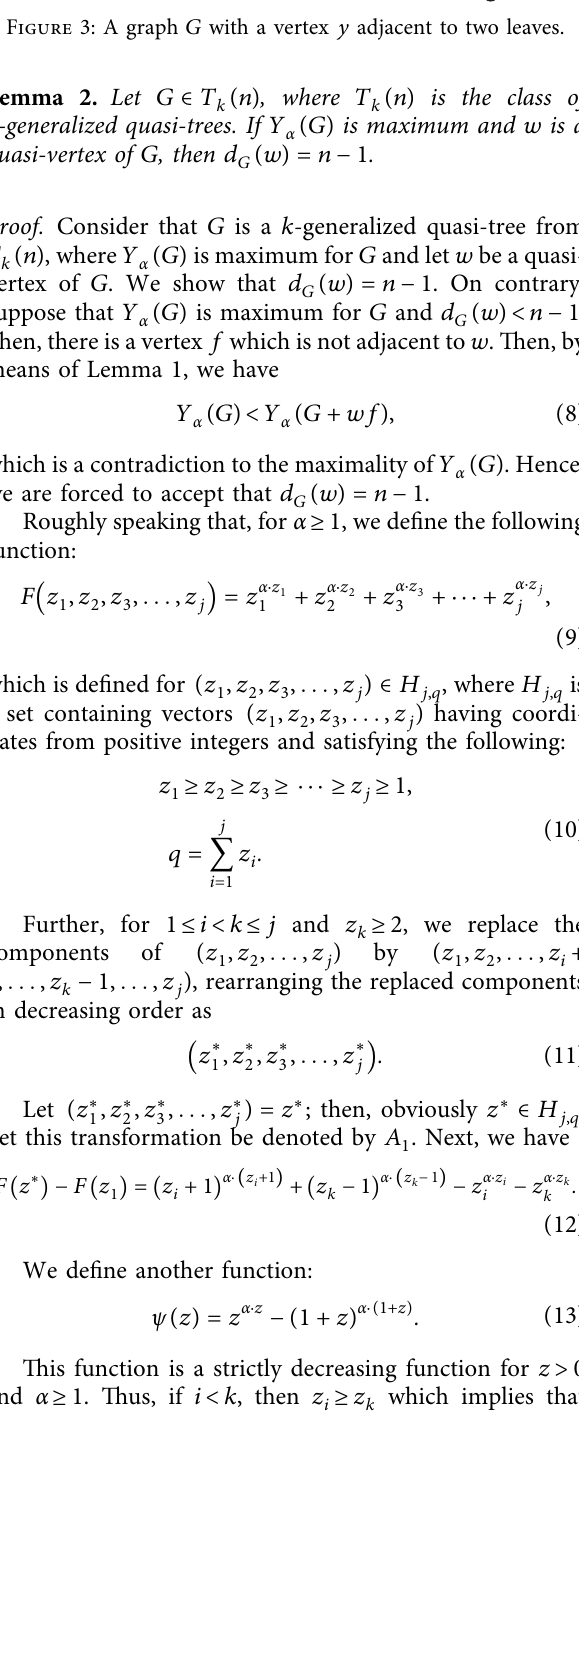
Figure 3: A graph G with a vertex y adjacent to two leaves.